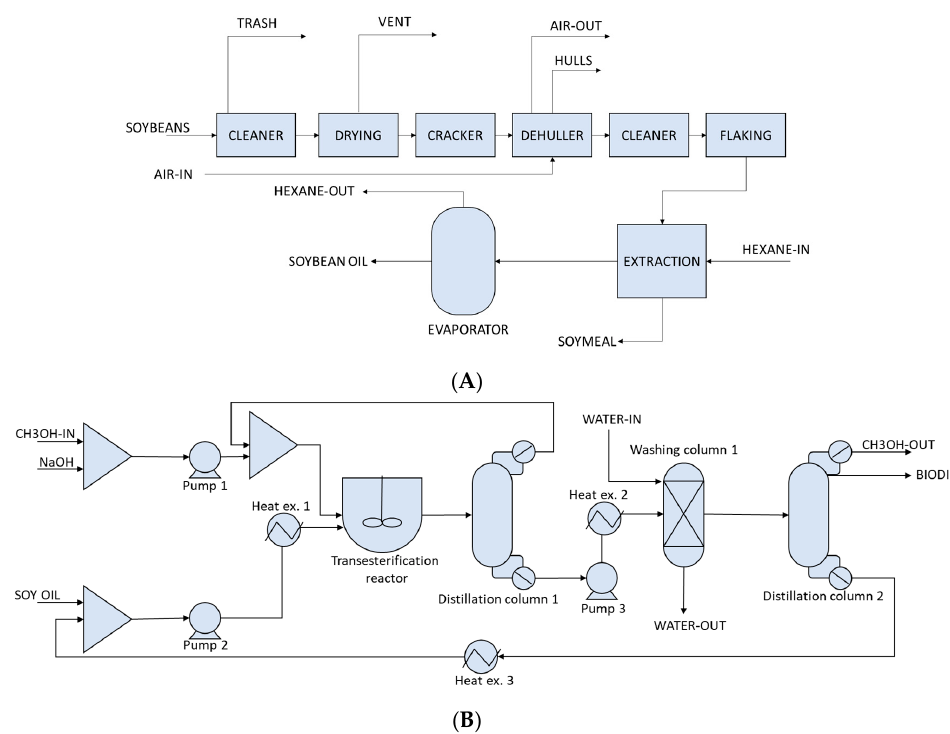
Figure 2. ( A ) Soybean to soybean oil conversion process flow diagram as used in Aspen plus; ( B ) Soybean oil to soy biodiesel production Process Flow